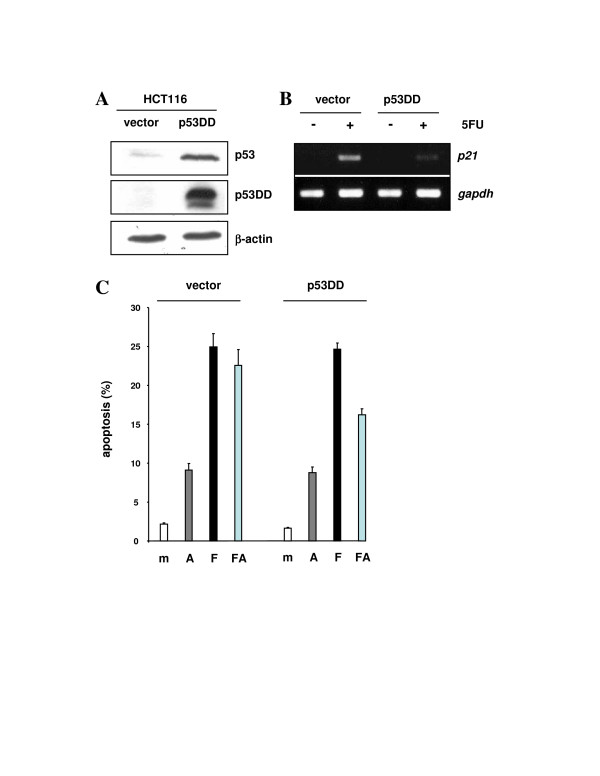
Dominant inhibitory effect of p53DD on transcription but not mitochondrial apoptosis. (A) Western immunoblot on 30 μg of total protein extract from HCT116 cells expressing vector-only or p53DD, documenting the expression levels of endogenous wt p53 and p53DD. p53DD was detected with antibody PAb421 (1:200); loading control β-actin was detected with anti-β-actin antibody diluted at 1:5000. (B) RT-PCR on total RNA prepared from the indicated cell lines at 24 h after mock-treatment or treatment with 375 μM 5FU. The primers were specific for the p53-regulated p21 transcript and for the gapdh transcript as a control. (C) Percentage of apoptosis in the indicated cell lines and at 48 h after mock-treatment or exposure to α-amanitin (10 μM; A), 5FU (375 μM; F), or both combined (FA). Apoptosis was measured by determining the numbers of cells with a sub-2n DNA content after PI staining, as described in Materials and methods.